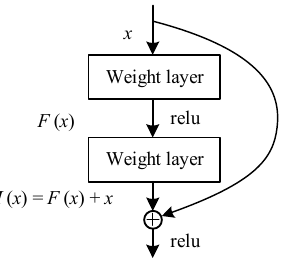
Figure 2. The basic blocks of residual networks.